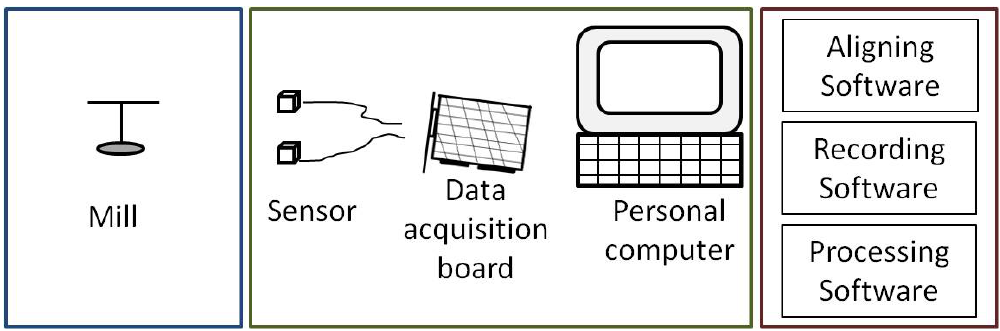
Figure 1. Functional blocks of the proposed flight mill.